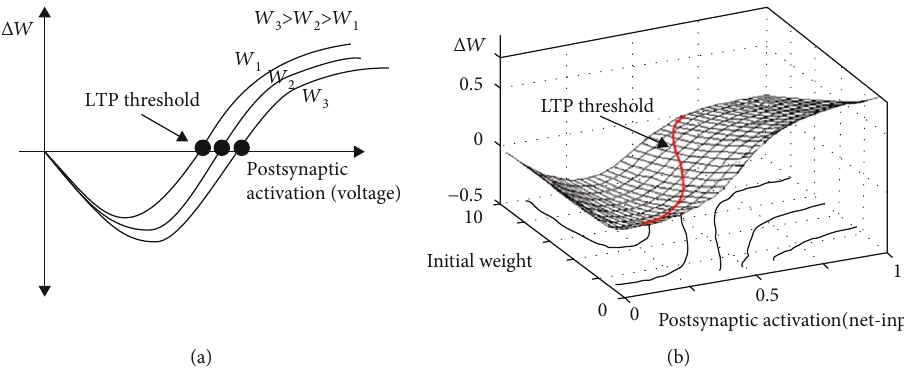
Figure 12: (a) Shape of curves obtained with real neurons for di ff erent initial synaptic weights w i . In this case, the experiment consisted of injecting current in the presynaptic neuron and measuring the postsynaptic voltage. The point where curves cross the horizontal axis is called the long-term potentiation threshold. (b) Family of curves obtained in the computer model through the presynaptic rule (adapted from Figure 2 in [105]). Both graphs exhibit metaplasticity: the rightward elongation of the curves along the horizontal axis for higher values of initial synaptic weights. For a more detailed explanation of how the curves were obtained, we suggest the reader to study References ([105] (Section 2), ([22]